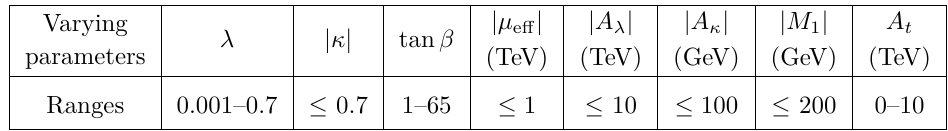
Table 1 . Ranges of various model parameters employed for scanning the Z 3 -symmetric pNMSSM parameter space. All parameters are defined at the scale Q 2 = (2 m 2 tan β which is defined at m . Masses of the gluino and all sfermions from the first two generations Z (third generation) are kept fixed at 5 TeV (5.5 TeV). The wino mass, M